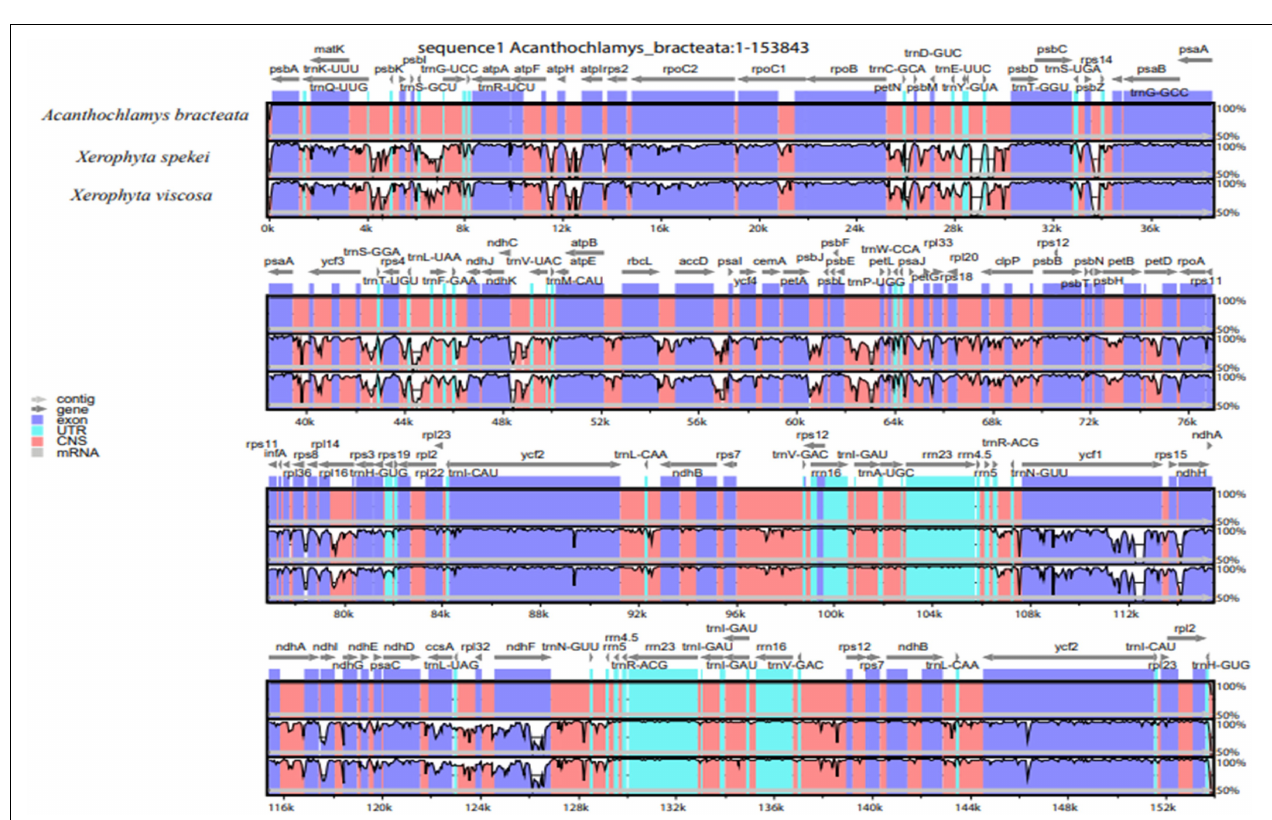
FIGURE 8 | Junction sites comparison of the chloroplast genomes of the three species. JLB: junction line between LSC and IRb; JSB: junction line between IRb and SSC; JSA: junction line between SSC and IRa; JLA: junction line between IRa and LSC.